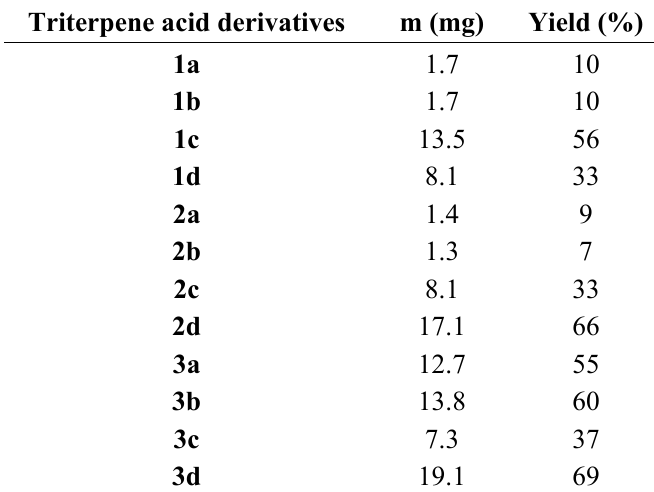
Table 4. Yields * of purified ester triterpene acid